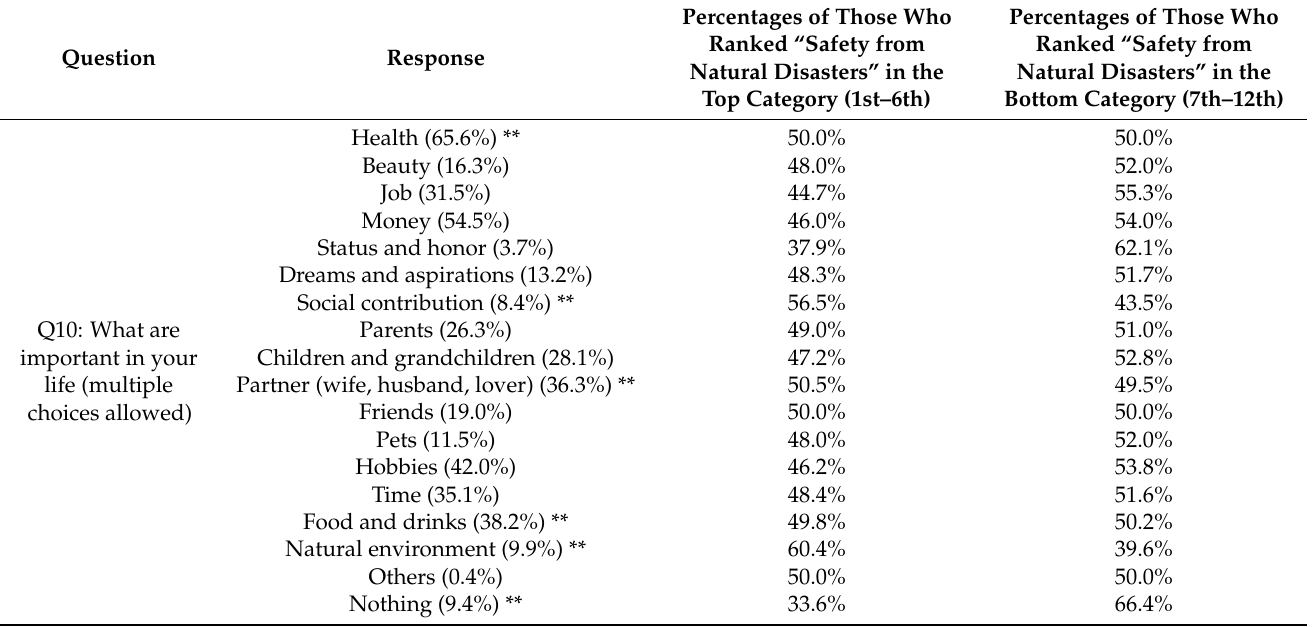
Table 2. Cross-tabulation results of items which are important in life and the relative preference of “safety from natural disasters” in residential choices ( n = 1554). The number in parentheses indicates the percentage of the response for each